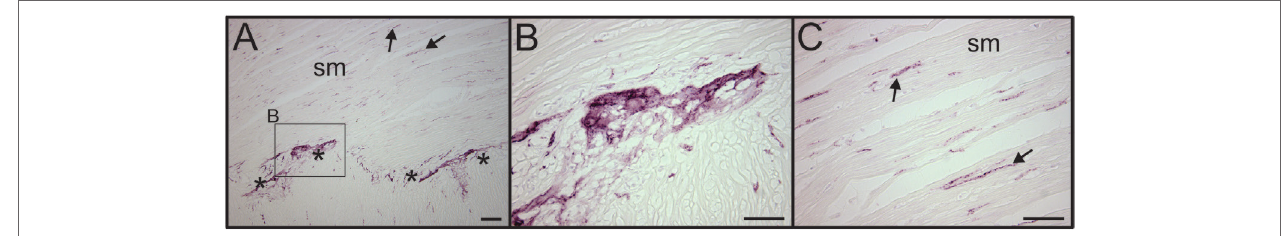
FigUre 6 | VAChT antibody labels cholinergic nerve fibers in human intestine. (a) Low magnification image showing the presence of VAChT + cholinergic nerve fibers in a section of human intestine that was stained along with spleen sections. Asterisks indicate a ganglionated nerve plexus. Boxed region contains a ganglion shown at high magnification in panel (b) . Arrows indicates two of many VAChT nerve fibers that innervated intestinal smooth muscle (sm). (b) VAChT + nerve fibers surrounding an enteric ganglion. (c) VAChT + nerve fibers in sm region shown at higher magnification. Scale bars: 100 µm (a) ; 50 µm (b,c) .